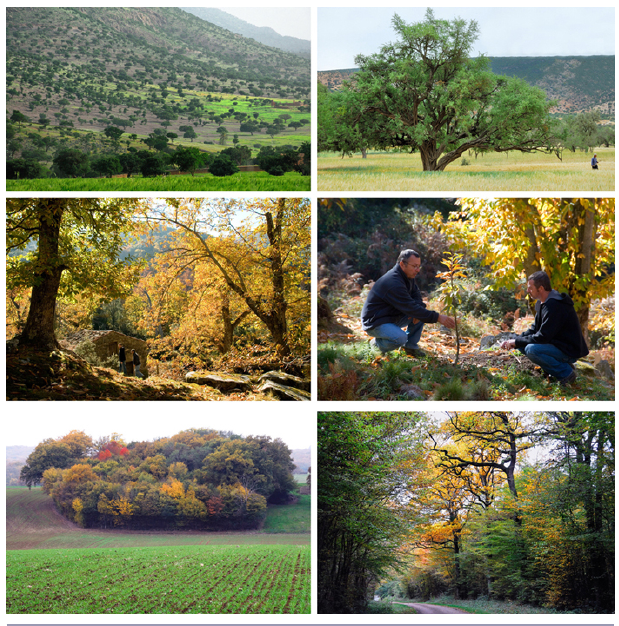
Fig. 1 . Rural forests: Argan forest in Morocco (above), chestnut forest in Corsica (middle), farmers’ forest in France